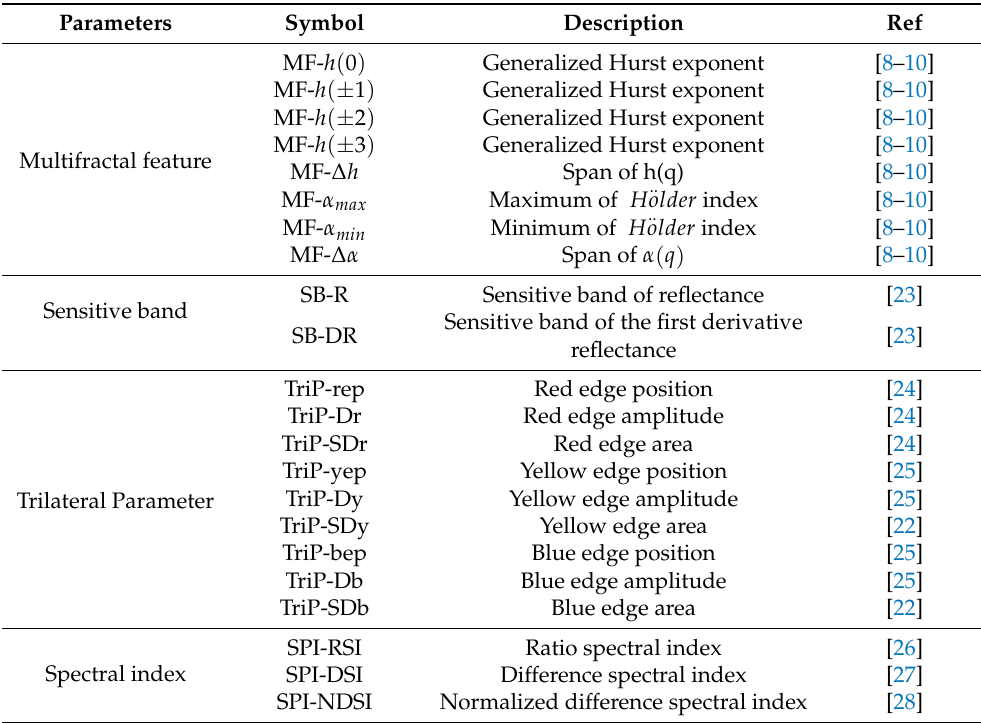
Table 2. Hyperspectral characteristic